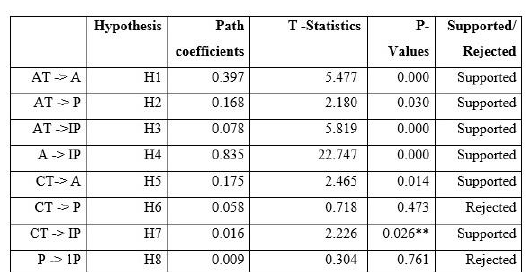
Figure 2. Structural Model of the Path Coefficient Table 5: Structural Analysis